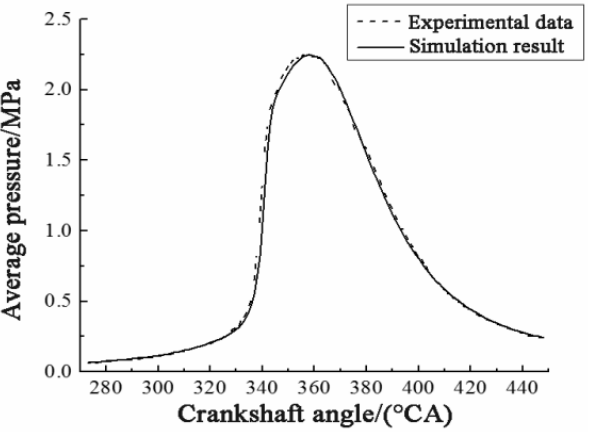
Figure 7. Comparison of numerical simulation results with experimental results.